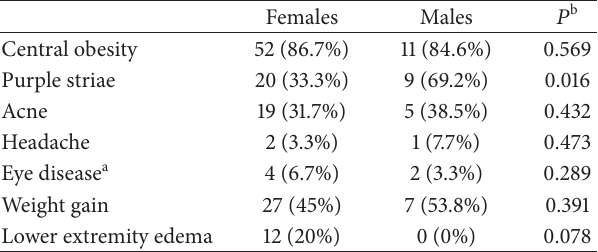
Table 3: Differences in clinical presentation of CD by